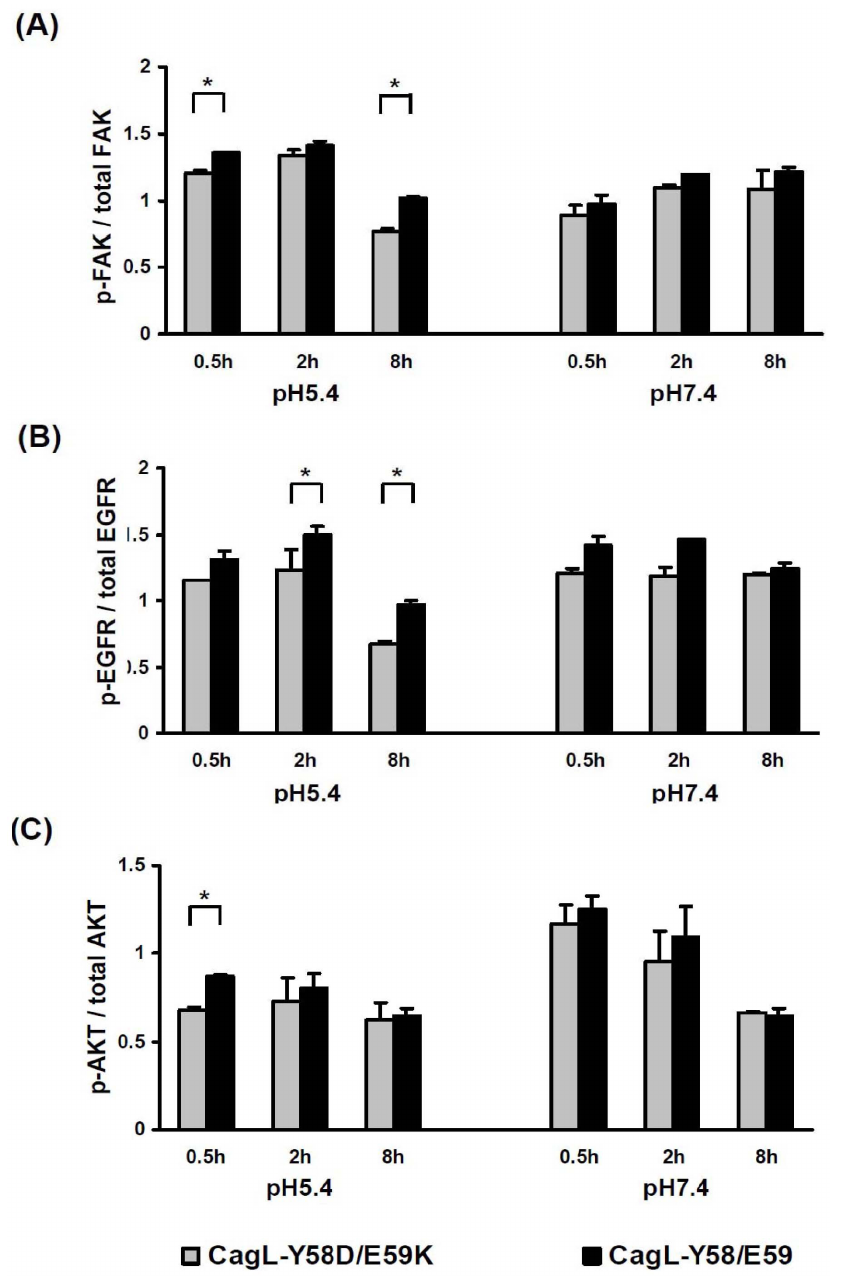
Figure 3. H.pylori CagL-Y58/E59 mediated stronger downstream signaling of FAK, EGFR and AKT than CagL-Y58D/E59K did. The AGS cells were co-cultivated with CagL-Y58/E59 or CagL-Y58D/E59K H. pylori at pH 7.4 or pH 5.4 to check the expression ratios of ( A ) phospho-FAK & FAK, ( B ) phospho-EGFR & EGFR, and ( C ) phospho-AKT & AKT. There were significant differences in phosphorylation level of FAK, AKT at pH 5.4 and EGFR at pH 5.4 and 7.4 triggered between CagL-Y58/E59 or CagL-Y58D/E59K H. pylori (* p , 0.05). The data were mean 6 standard deviations.